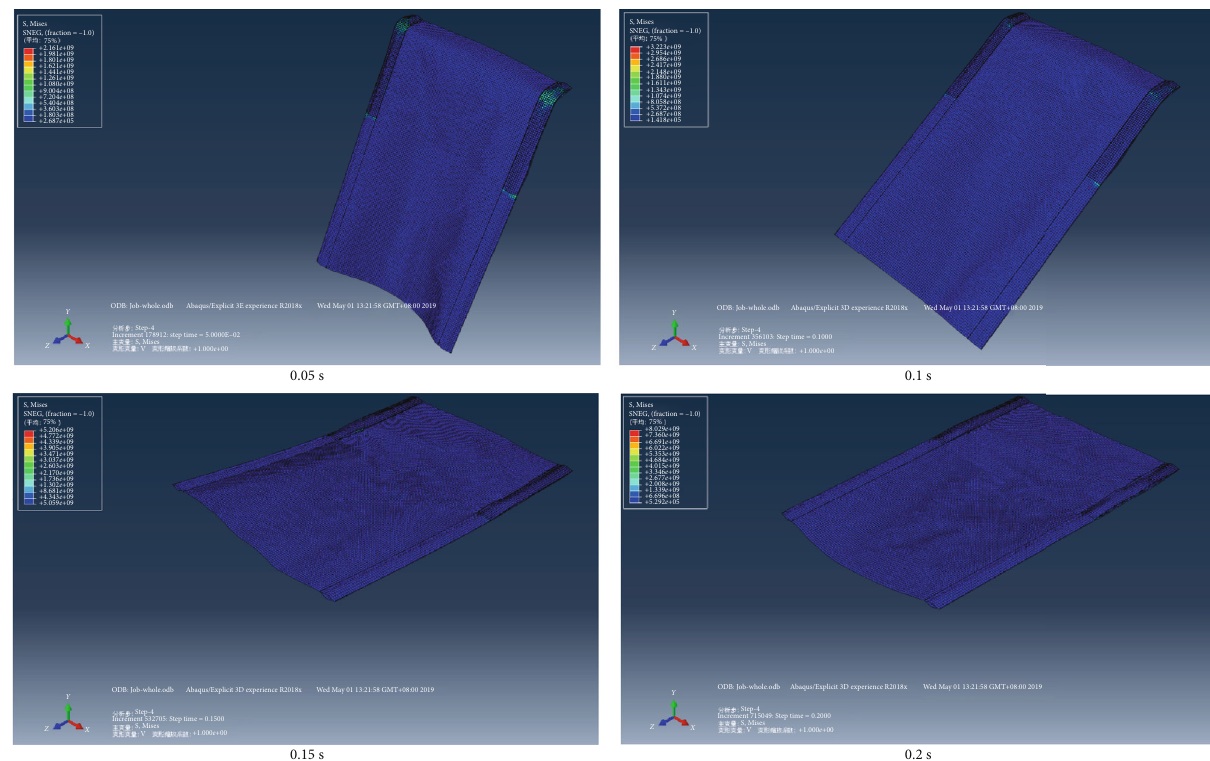
Figure 17: Dynamic behaviors of self-deployable sunshields.